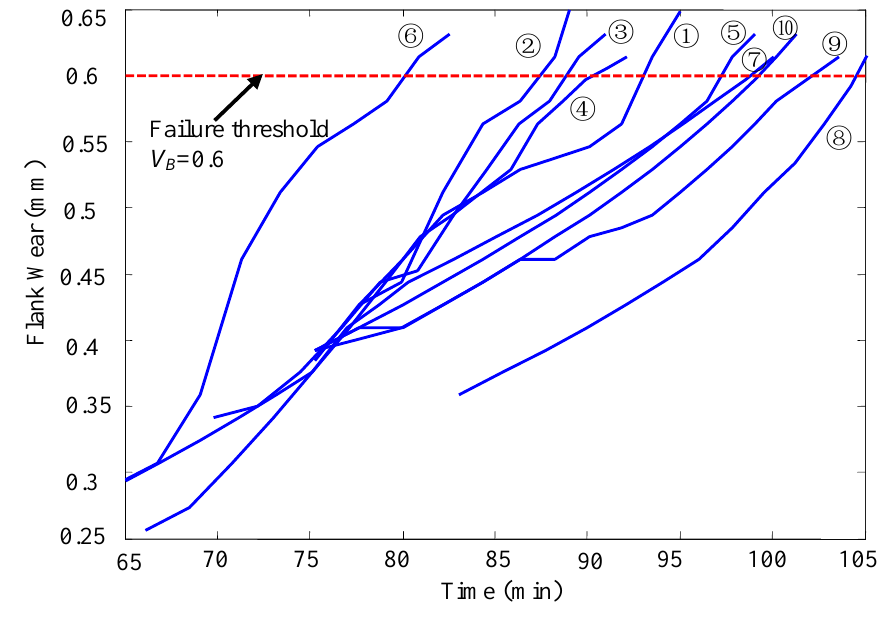
Figure 4. Variation curves of the cutting tools flank wear values.